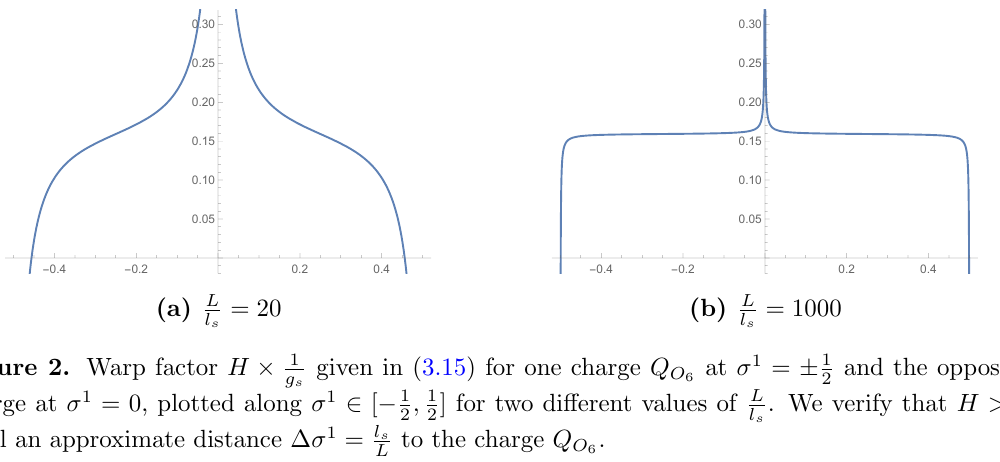
given in (3.15) for one charge Q O at (cid:27) 1 = (cid:6) 1 and the opposite g s 2 6 ; 1 ] for two di(cid:11)erent values of L . We verify that H > 0 2 2 l s to the charge Q O L 6